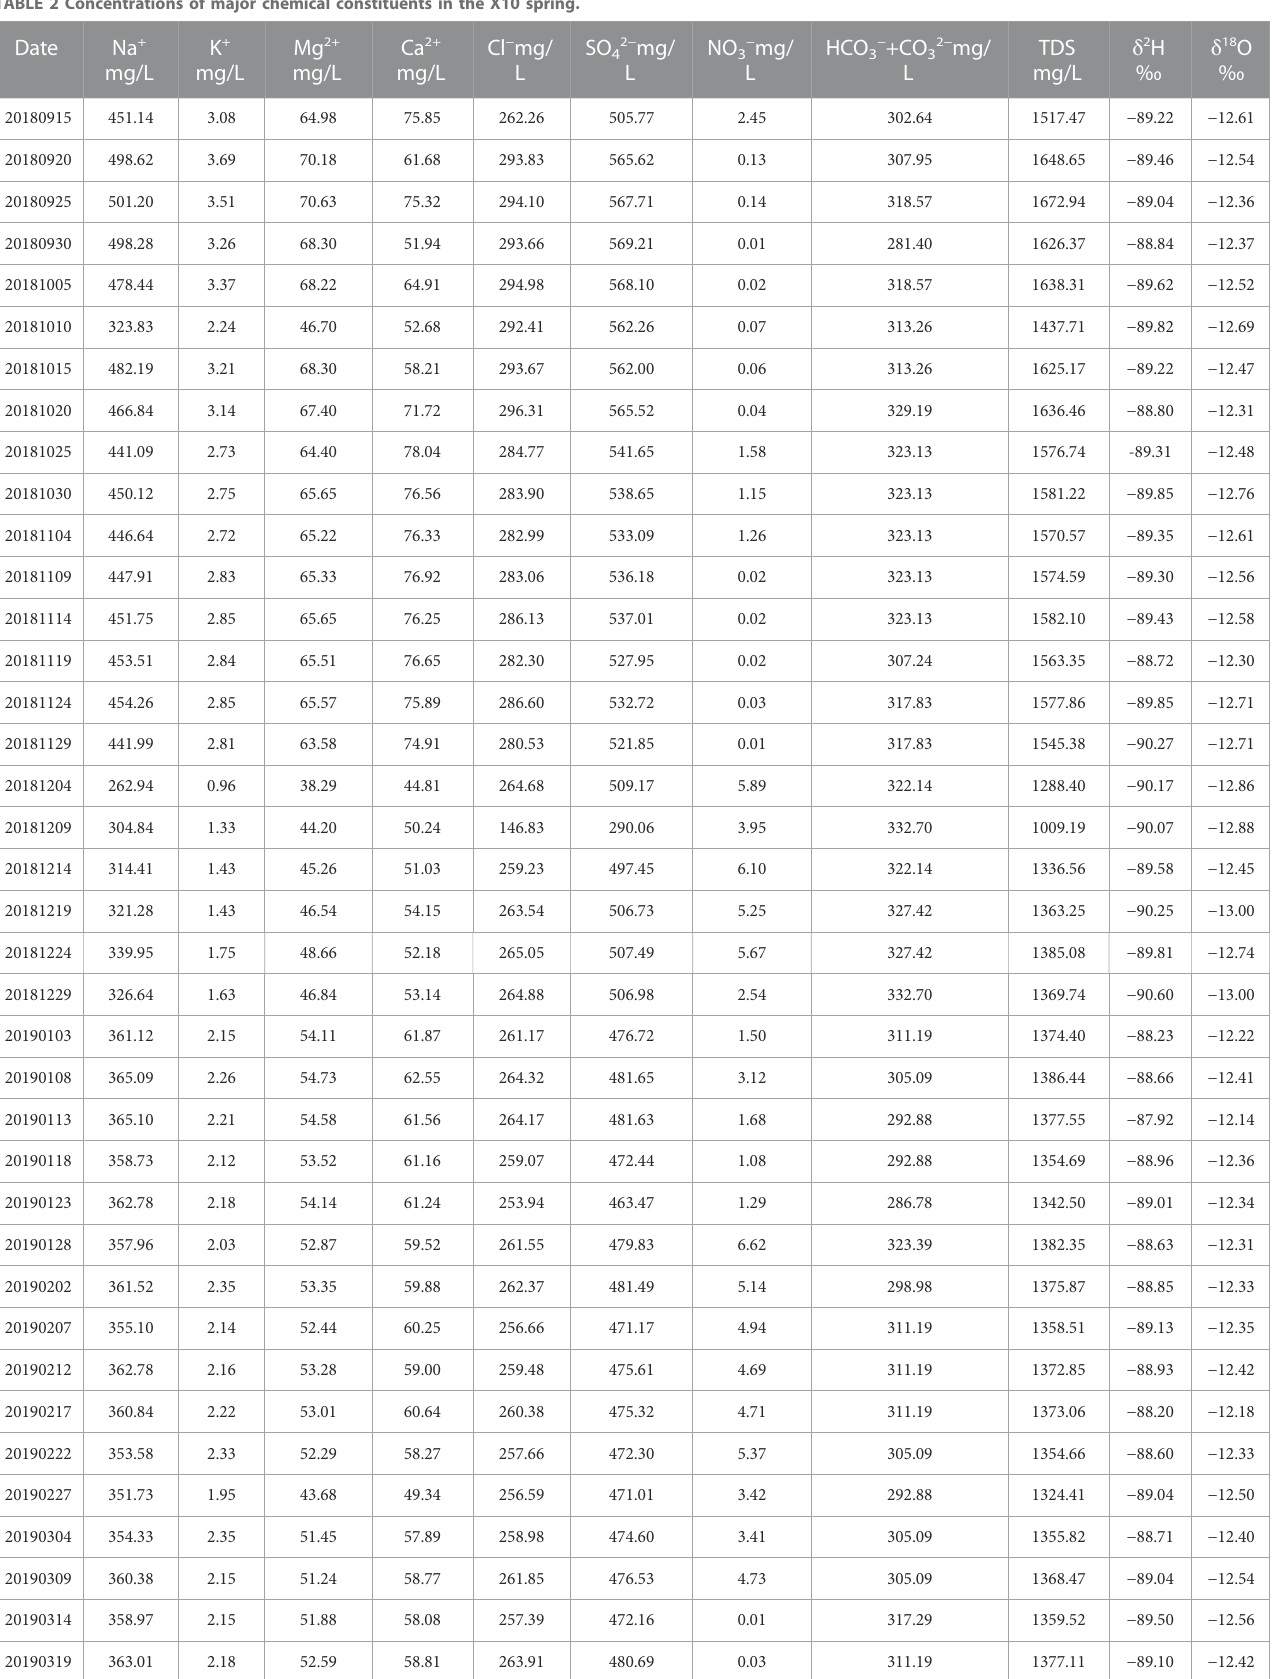
TABLE 2 Concentrations of major chemical constituents in the X10